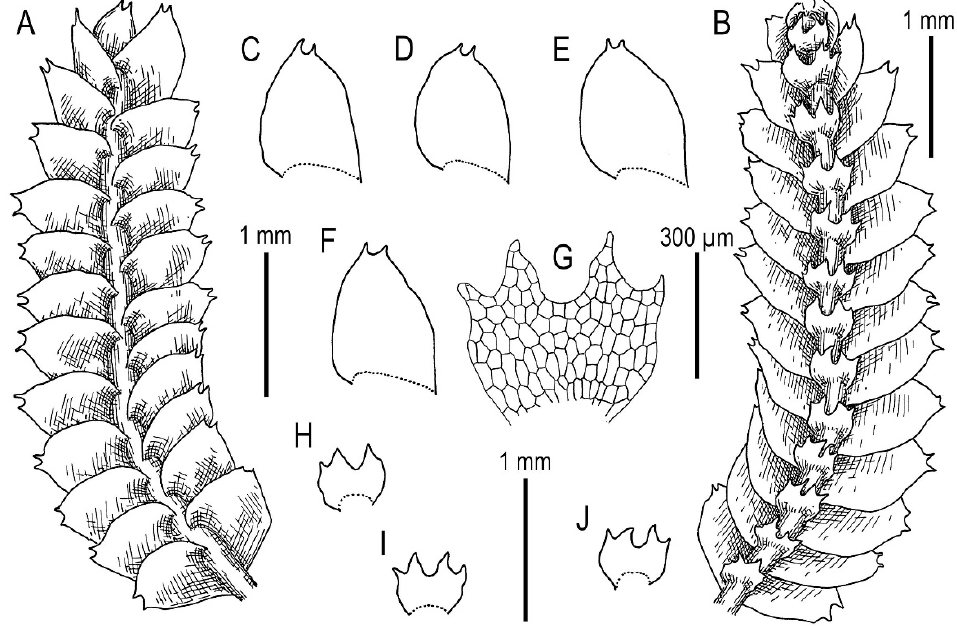
Figure 11. Calypogeia tosana (Steph.) Steph.: ( A ) Plant habit, fragment, dorsal view; ( B ) Plant habit, fragment, ventral view; ( C – F ) Leaves; ( G – J ) Underleaves. All from V-3-73-17 (VBGI). Calypogeia vietnamica Bakalin et Vilnet Herzogia 32 (1): 225, 2019. Type: Vietnam, Lao Cai Province, SaPa District, San Sa Ho Commune, Hoang Lien Range, Phan Xi Pang Peak area (22°18.45 ′ N, 103°46.567 ′ E), 2900 m a.s.l., 20 April 2017, V.A. Bakalin & K.G. Klimova, V-9-23-17 (holotype: VBGI!).